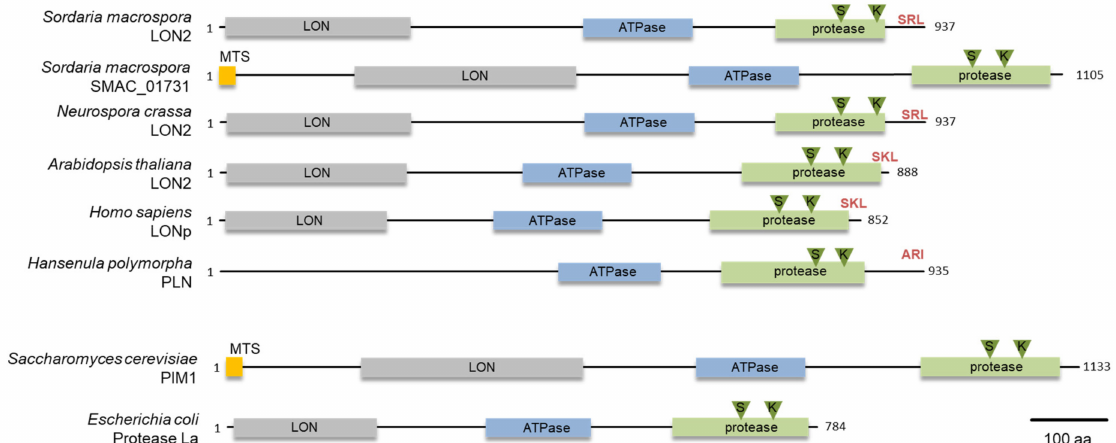
Figure 1. Domain organization of Lon proteases from fungi, plants, animals and bacteria. Domains were predicted with programs SMART [42] and Prosite [43], the mitochondrial targeting signal (MTS) indicated in orange was predicted with the program MitoFates [44]. The N-terminal Lon domain is indicated in grey, the ATPase domain is indicated in blue and the protease domain is depicted in green. The PTS1 sequence is shown in red and the S and K residues of the protease catalytic dyad is marked by green triangles. An N-terminal LON domain was not predicted for PLN of H. polymorpha . Accession numbers of the proteins are the following: S. macrospora SmLON2 (KAA8632750.1), S. macrospora SMAC_01731 (XP_024511168.1) N. crassa LON2 (NCU08303, XP_962516.1), A. thaliana LON2 (NP_568675.1), Homo sapiens LONp (NP_113678.2), H. polymorpha PLN (ABB88892.1), Saccharomyces cerevisiae PIM1 (CAA84841) and E. coli La